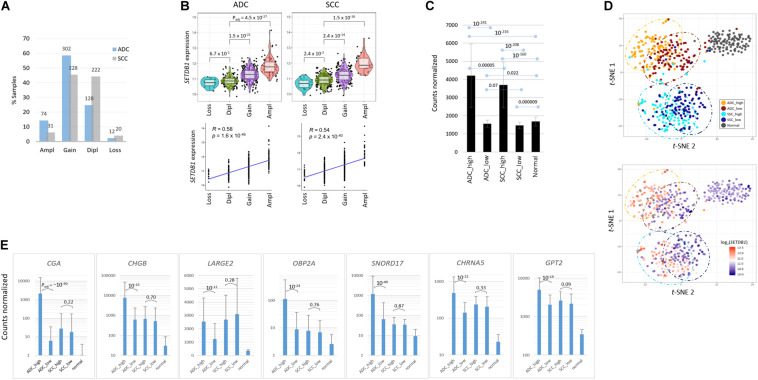
Transcriptomic differences between SETDB1-high and SETDB1-low tumor samples in lung adenocarcinoma (ADC) and squamous-cell carcinoma (SCC). (A) The frequency of the SETDB1 gene copy number alteration (CNA) in The Cancer Genome Atlas (TCGA)-deposited lung ADC and SCC samples. The X-axis represents the types of CNAs (Ampl/Gain, more than wild-type copy number; Dipl, wild type; Loss, heterozygous or homozygous deletion), whereas the Y-axis indicates the fraction of each CNA type in the lung cancer samples. The actual number of samples is denoted on each bar. Ampl, amplification; Dipl, diploid. (B) A high correlation between the SETDB1 CNA (x-axis) and expression (y-axis). Violin plots showing SETDB1 expression levels in samples with SETDB1 CNA. A statistical significance (Wilcoxon signed-rank test) of each CNA type against the Dipl group is indicated. (C) The mean SETDB1 expression levels in SETDB1-high and SETDB1-low samples of lung cancer groups. Adjusted p-values are indicated between sample groups. The error bars indicate standard deviation. ADC/SCC-high/ADC/SCC-low, ADC, or SCC samples with high or low SETDB1 expression levels. (D) The t-SNE plots of lung cancer samples. Samples are colored by group names (i.e., the SETDB1 expression level and lung cancer types) in the upper panel and by the SETDB1 expression levels in the lower panel. (E) Differentially expressed genes (DEGs) in SETDB1-high ADC tumors. ADC SETDB1-high specific DEGs were chosen between ADC SETDB1-high and normal samples (Padj < 10– 50) for the first round, and the resulting groups of genes were compared between SETDB1-high and SETDB1-low samples in ADCs (Padj < 10– 10) and, simultaneously, in SCCs (> 0.01) for the second round. Adjusted p-values are indicated.